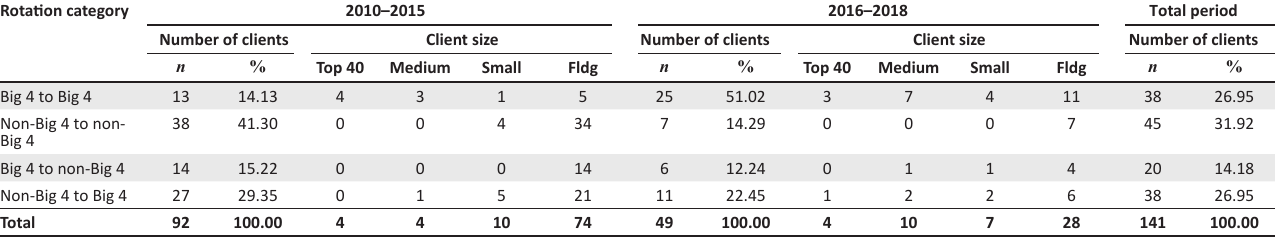
TABLE 5 : Audit firm rotations per audit firm size and client